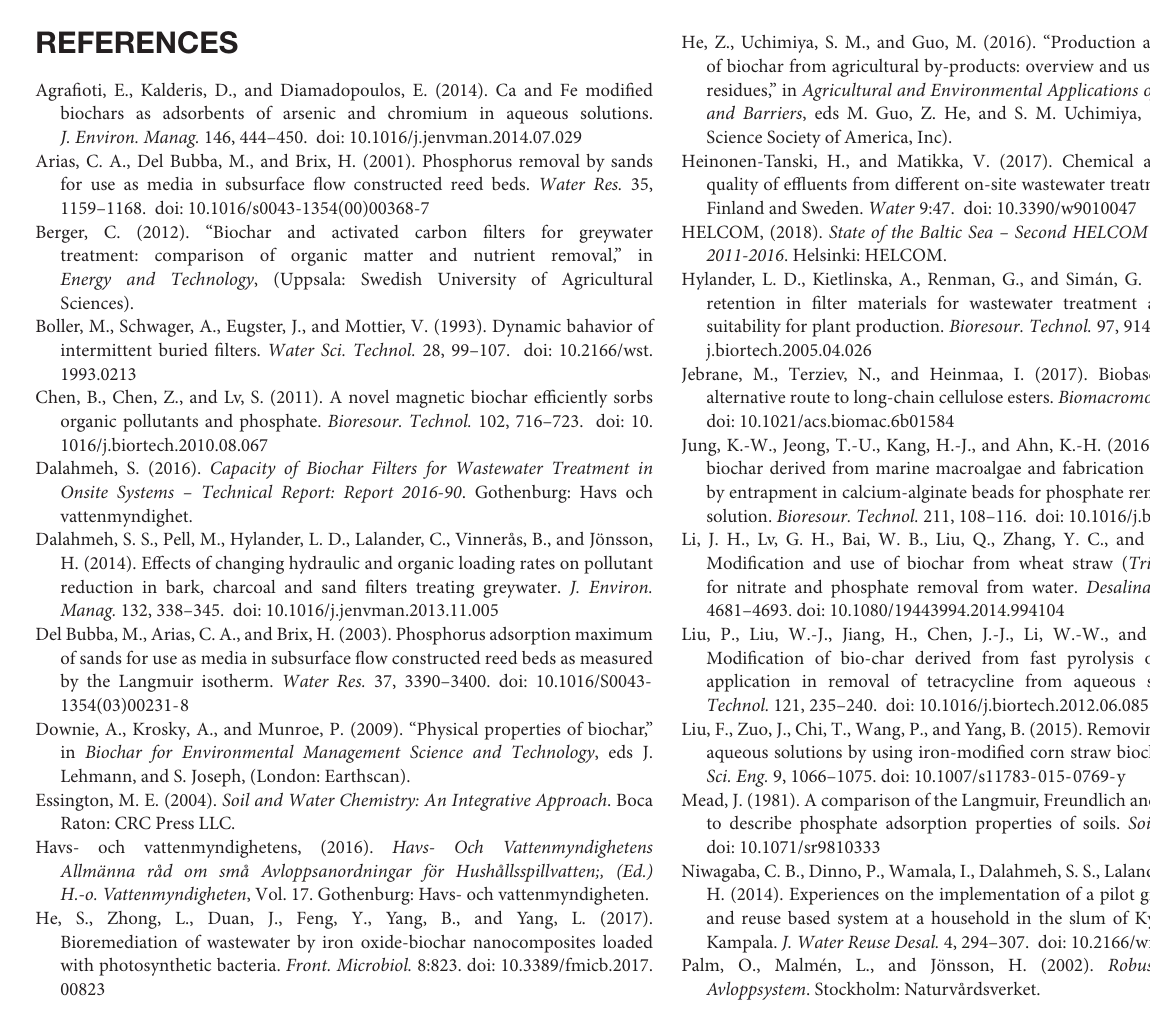
Supplementary Figure 1 | Scanning electron microscope images of (A) unimpregnated biochar filter (UBC), (B) CaO-impregnated biochar filter (CBC), (C) FeCl 3 -impregnated biochar filter (FBC), and (D) biochar filter mixed with Polonite R (cid:13) (PBC). All images are shown at 10 µ m resolution except Polonite (20 µ m). Supplementary Figure 2 | X-ray diffraction patterns of untreated biochar (UBC) and biochar impregnated with CaO (CBC), before and after use for wastewater filtration. Supplementary Figure 3 | X-ray diffraction patterns of biochar treated with FeCl 3 (FBC) and biochar mixed with Polonite, before and after use for wastewater filtration. Supplementary Figure 4 | Percentage removal of phosphate-phosphorus (PO 4 -P) in (A) unimpregnated biochar filter (UBC), (B) CaO-impregnated biochar filter (CBC), (C) FeCl 3 -impregnated biochar filter (FBC), and (D) biochar filter mixed with Polonite (PBC), as a function of time at P loading rate (PLR)-194 ( • ), PLR-324 ( (cid:4) ), PLR-652 ( (cid:78) ) and PLR-1715 ( (cid:7)